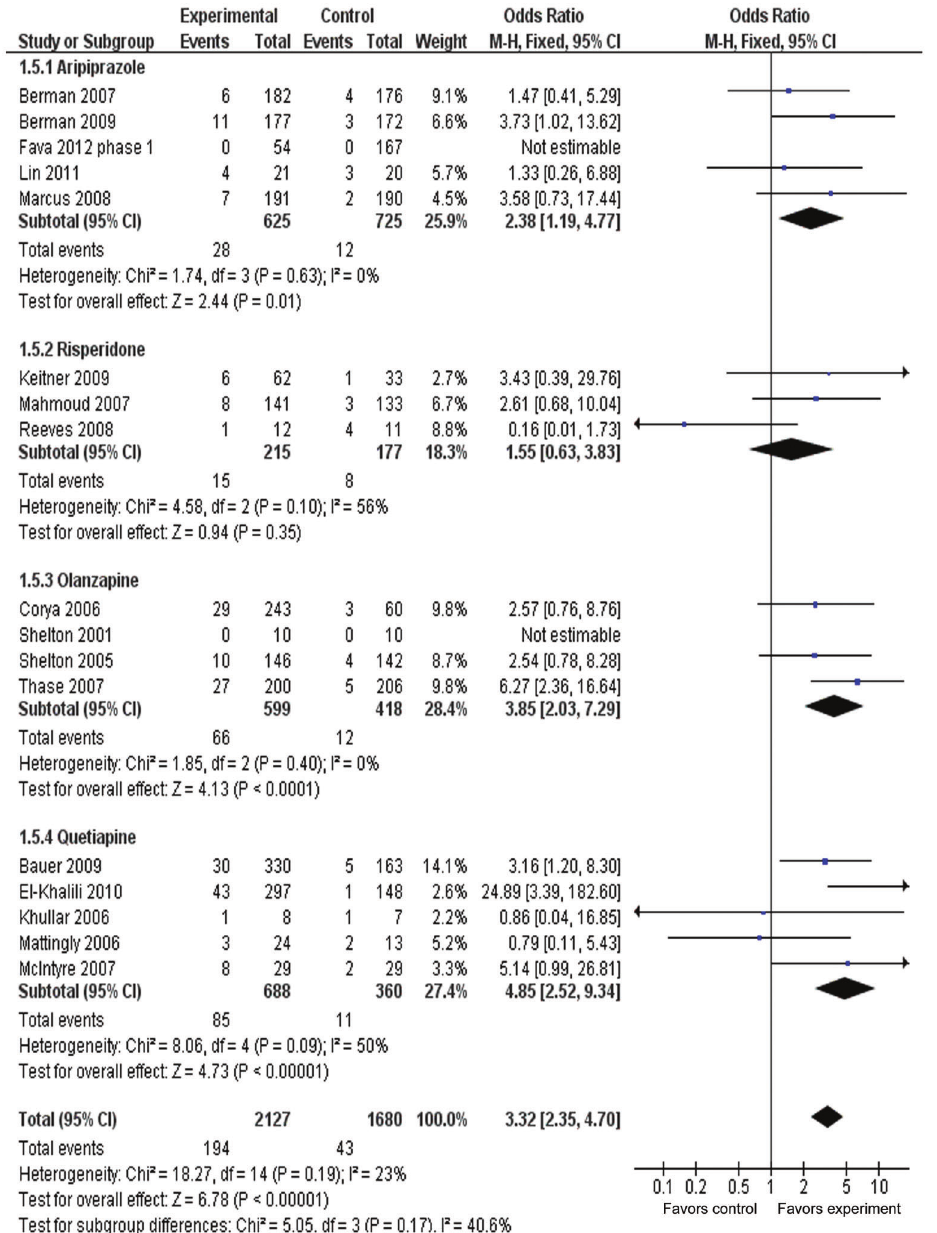
Figure 7. Meta-analysis of discontinuation rate due to adverse effect of adjunctive atypical antipsychotics in major depressive disorder. Odds ratios for discontinuation due to adverse effects to drug and placebo are grouped by different atypical antipsychotics. Thase et al. (29) contains two identical trials; we combined them to analyze discontinuation rate. All trials were included in this subgroup